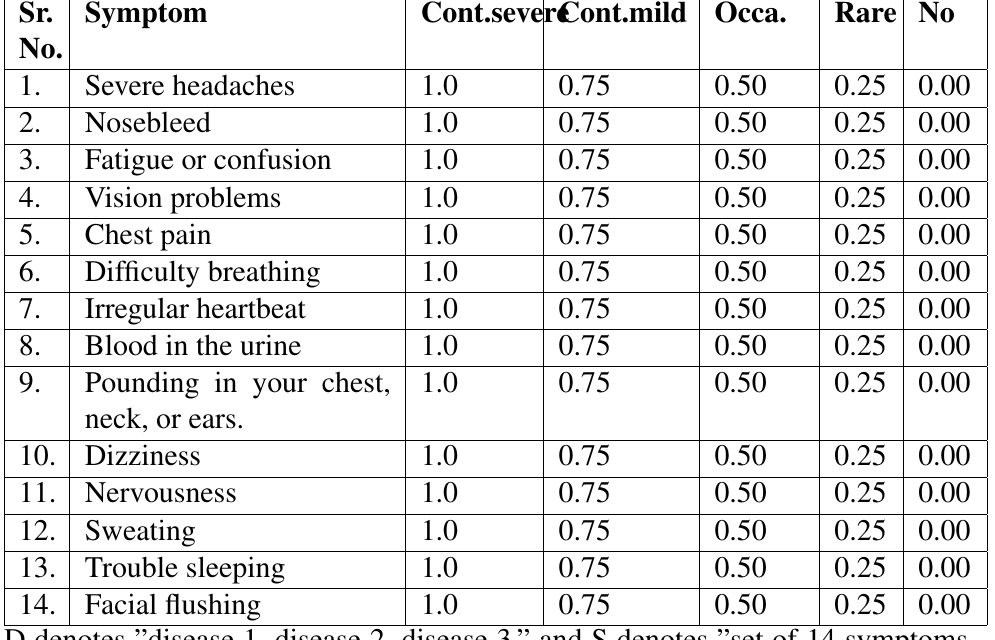
Table 1: A patient’s symptoms according to their frequency or intensity Sr.